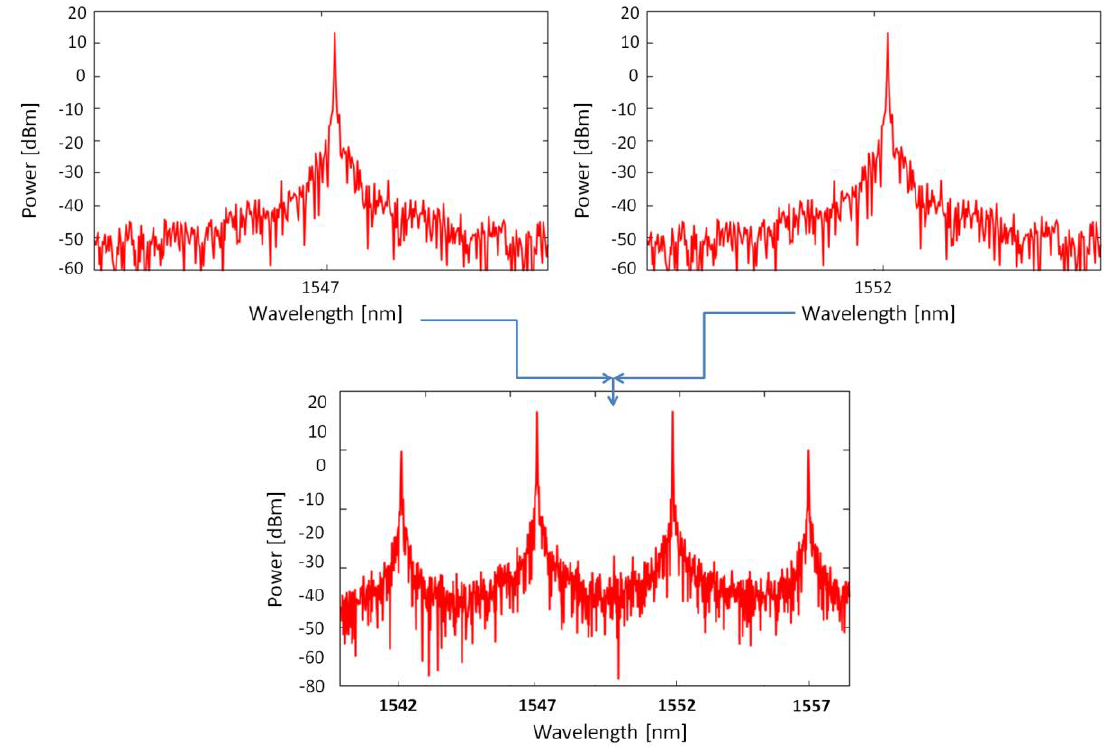
Figure 1. Illustration of the Four Wave Mixing (FWM) process in a Highly Nonlinear Fibre